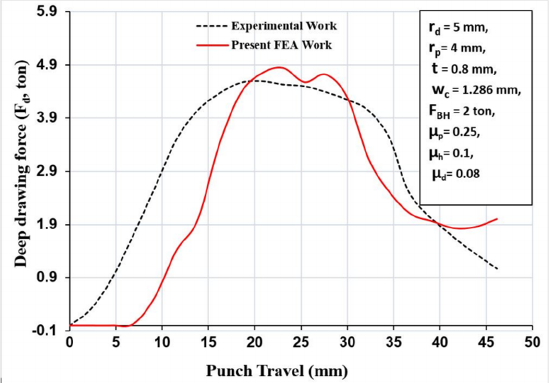
Figure 17. Deep drawing force as a function of punch travel for validation between experimental work and the FE analysis.